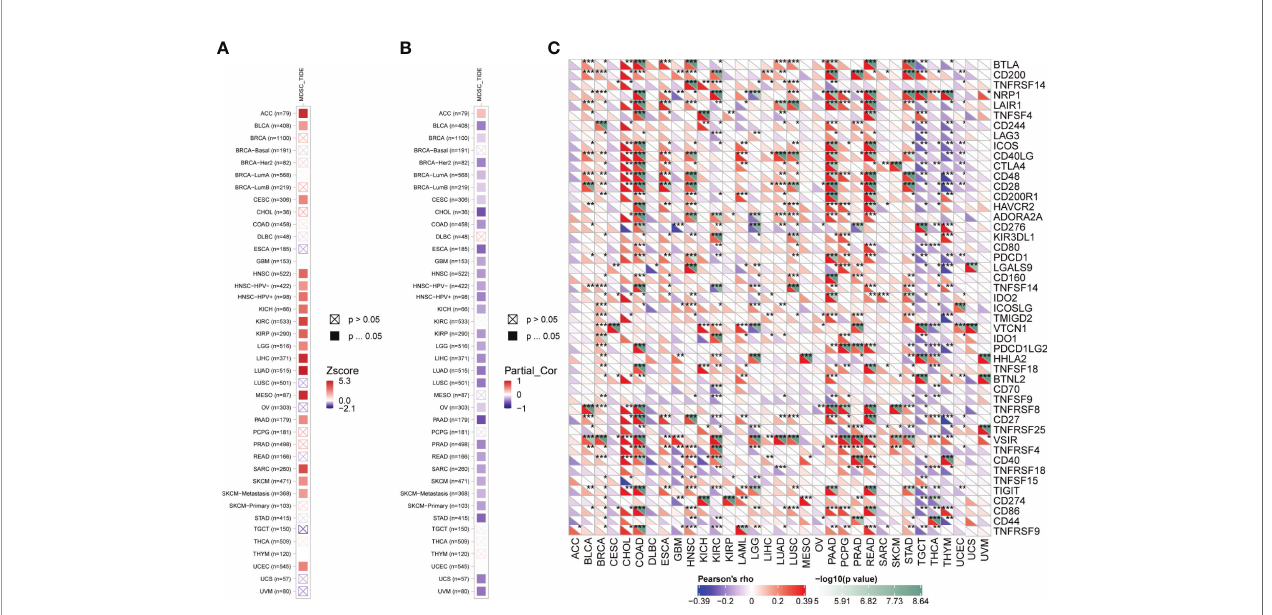
FIGURE 5 | Immune in fi ltration analysis of FAM107A. (A) The correlation between the in fi ltration level of MDSCs and overall survival was explored across all types of cancer in TCGA. (B) The potential correlation between the expression level of the FAM107A gene and the in fi ltration level of MDSCs was explored across all types of cancer in TCGA. (C) The correlation between FAM107A mRNA expression and the expression levels of key immune checkpoints in different cancers from the TCGA database was investigated. *P < 0.05; **P < 0.01; ***P <